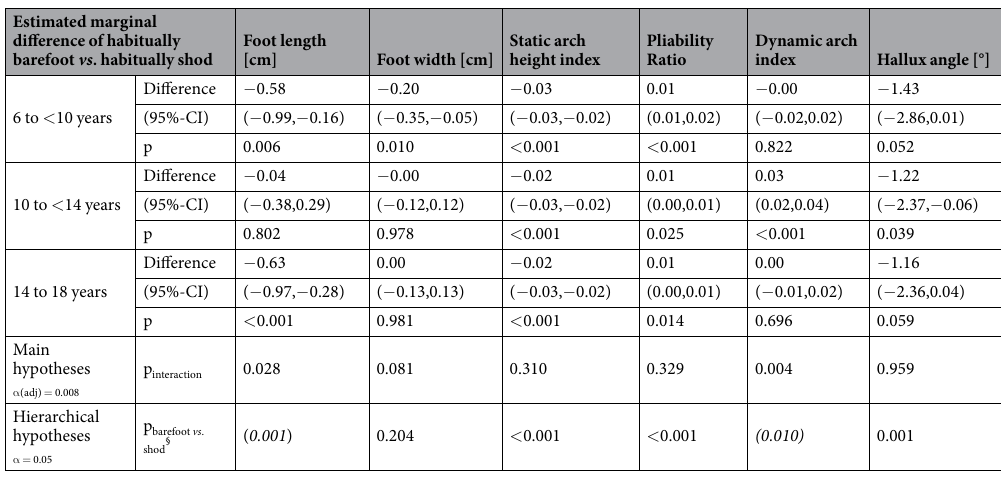
Table 2. Pairwise comparisons of habitually barefoot/shod children by age in stages of development. §In parentheses p-value of group-effect modeled without significant